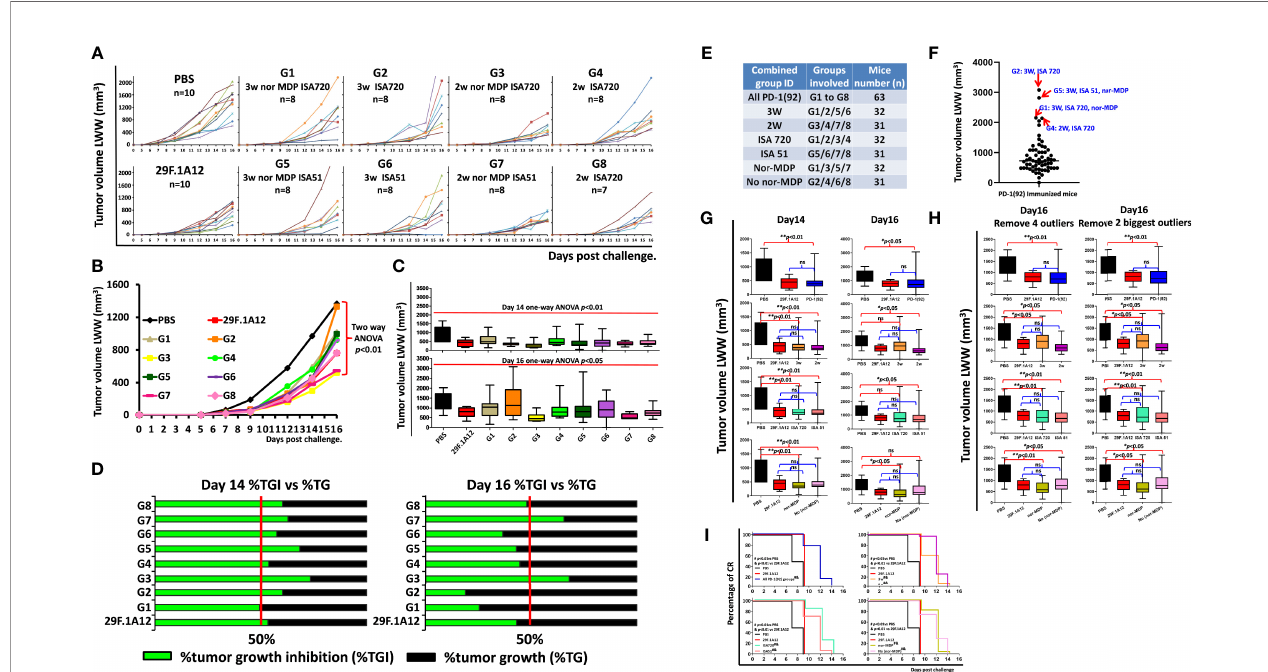
FIGURE 2 | Antitumor ef fi cacy in syngeneic BALB/c mice challenged with CT26 colon carcinoma cell line. (A) Individual plots of tumor growths in BALB/c mice immunized with MVF-PD-1 (92-110) vaccine, PBS as negative control, and anti-mouse PD-1 antibody (clone 29F.1A12) as positive control. As indicated, in the PBS and the mAb (29F.1A12) groups, n = 10, group 1 to group 7 n = 8, group 8 n = 7 (one mouse was lost in this group, resulting from an immunization-unrelated reason.) (B) Tumor burden (LWW) by days in BALB/c mice of each treatment group, and two-way ANOVA was used to analyze the whole curves of tumor growth. (C) Tumor burden (LWW) at day 14 and day 16 in BALB/c mice of each treatment group, and one-way ANOVA was used to analyze all 10 groups at each time point. (D) Percentage of tumor growth inhibition (%TGI) was used to compare the treatment groups with the PBS control group. The value was calculated by formula: %TGI=100* (MTV control − MTV test)/MTV control, both calculated at day 14 and day 16. (E) In this panel, we show the different combined groups: all PD-1(92); G1 – G8 with n = 63; 3W are groups 1/2/5/6 with n = 32; 2W are groups 3/4/7/8 with n = 31; ISA 720 are groups 1/2/3/4 with n = 32; ISA 51 are groups 5/6/7/8 with n = 31; nor-MDP are groups 1/3/5/7 with n = 32; no nor-MDP are groups 2/4/6/8 with n = 31; (F) Within all the combined PD-1(92) immunized mice (n = 63), the outlier analysis was performed by using GraphPad software; four of the outliers are indicated in the image; (G) At Day 14 and day 16, the tumor size in different groups was analyzed by one-way ANOVA; * p < 0.05, ** p < 0.01, ns, no statistical signi fi cance; (H) Further comparison analysis of day 16 tumor volume in different groups by removal of the 4 statistical outliers or the top two largest outliers; (I) the percentage of CR was de fi ned as tumor volume equal or less than 50 mm 3 for at least 3 consecutive measurements during the study. The log-rank (Mantel – Cox) test was used to compare the percentage of CR in multiple groups: # p < 0.01 versus PBS and p < 0.01 versus